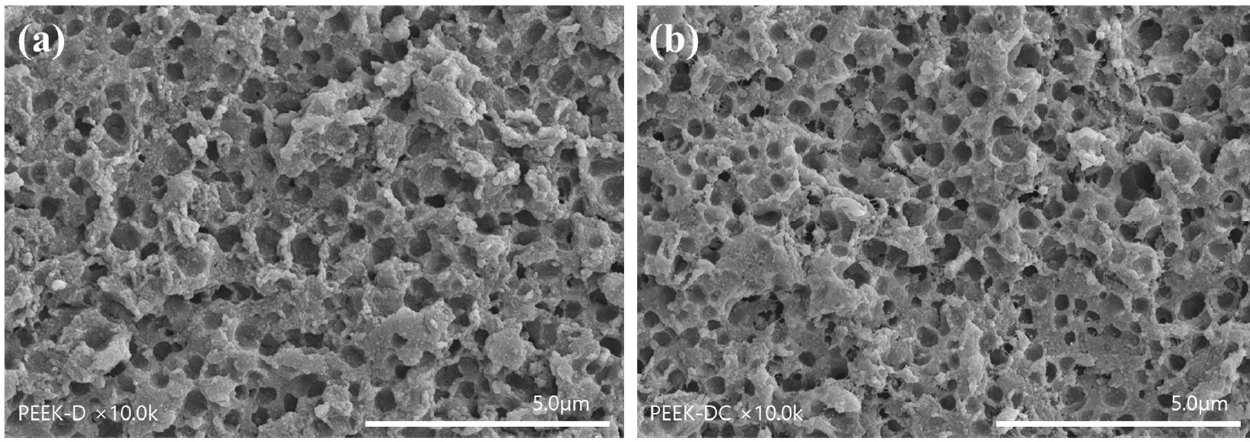
Figure 5. SEM images of porous PEEK coated with polydopamine ( a ) and porous PEEK sequentially immobilized with dopamine and collagen ( b ).